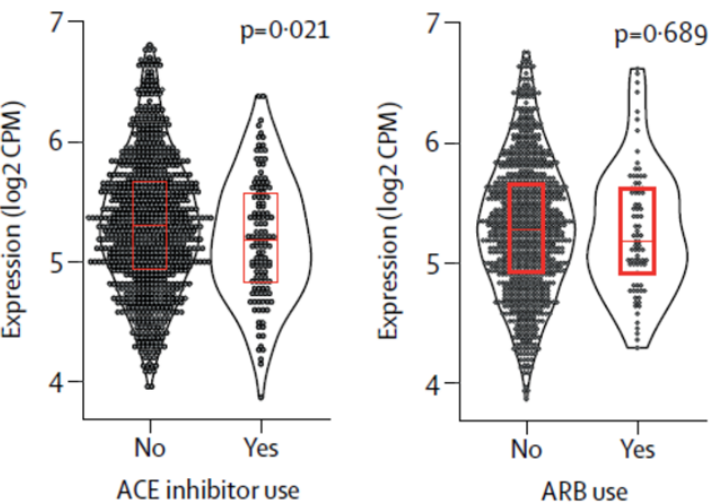
Figure 4. Effects of ACE inhibitor use, and ARB use on the expression of SARS-CoV-2 receptor (ACE2) in human lung tissue. Superimposed box plots show median (IQR). p values are from robust linear models, adjusted for current smoking status. ACE inhibitor use was associated with significantly lower ACE2 expression, whereas ARB was not. Abbreviations: ACE, angiotensin-converting enzyme; ARB, angiotensin II receptor blocker; CPM, counts per million; SARS-CoV-2, severe acute respiratory syndrome coronavirus 2 [89].